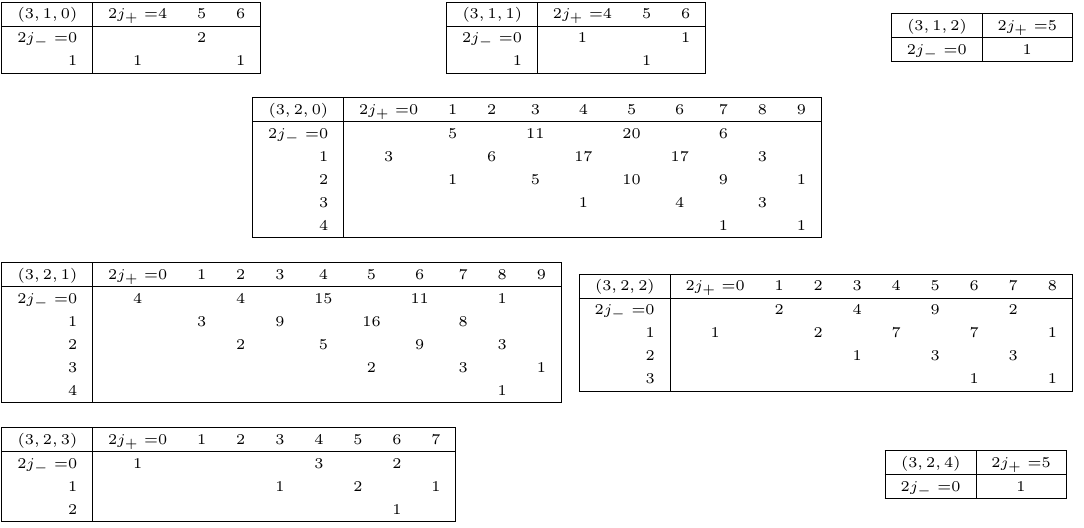
Table 17 . BPS numbers of massive M-string at base degree 3 and fiber degree 1 or